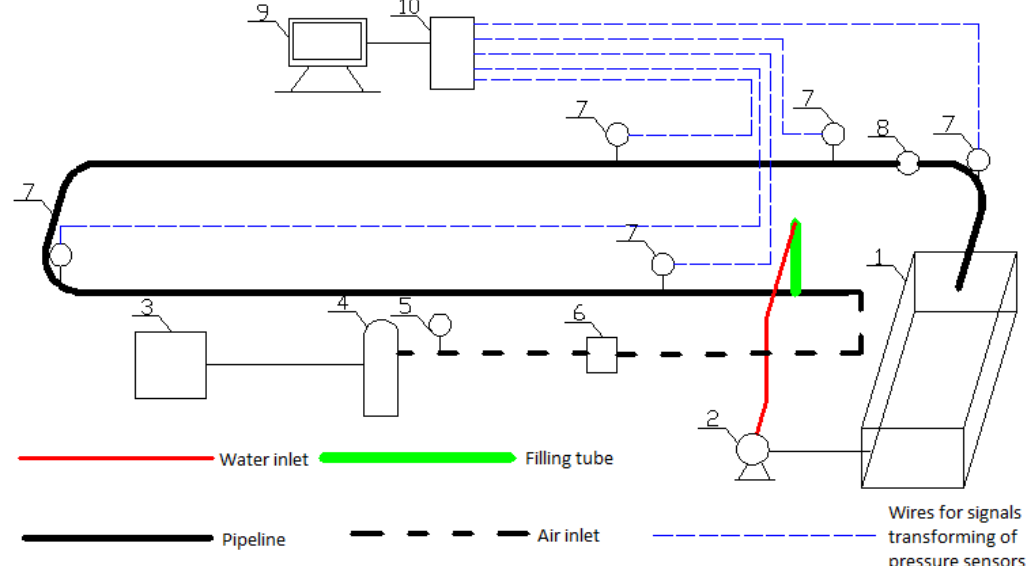
Figure 1. Experimental setup: (1) water tank; (2) water pump; (3) air compressor; (4) gasholder; (5) valve; (6) pulse generator; (7) pressure transmitter; (8) flow meter; (9) computer; and (10) data acquisition module.